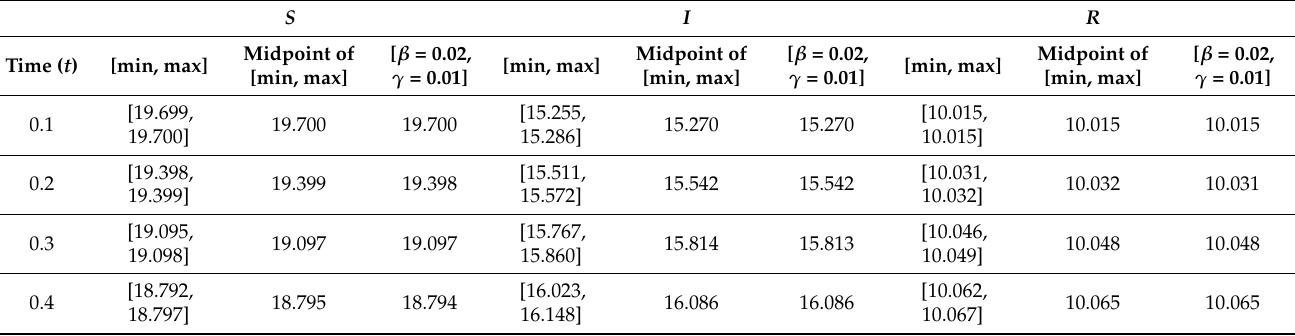
Table A2. The solutions obtained by the homotopy analysis method with the interval (cid:101) γ = [ 0.01, 0.015 ] and the constant value of β =